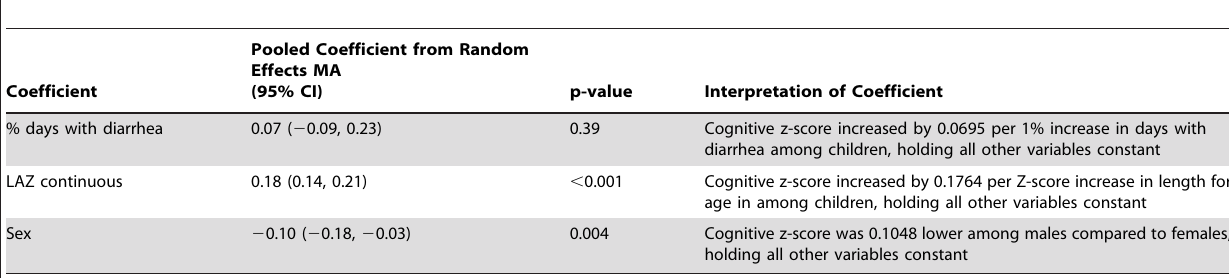
Table 3. Results Interpretation: Meta-analysis of the output from the regression of standardized cognitive z-score onto LAZ and diarrhea prevalence as continuous variables (model 1). a